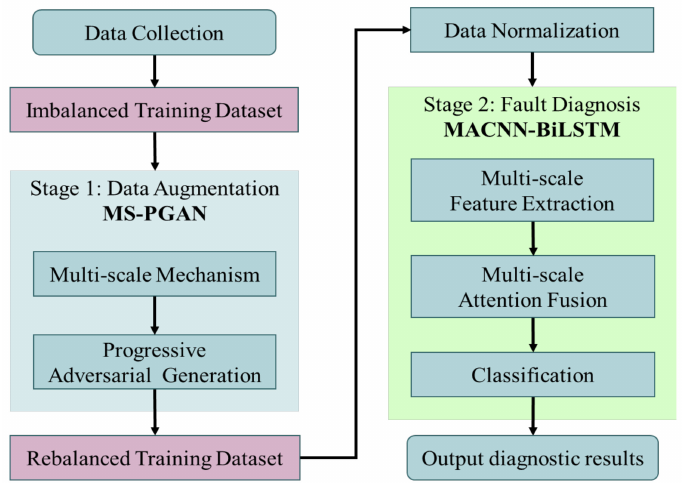
Figure 2. The flowchart of the proposed two-stage